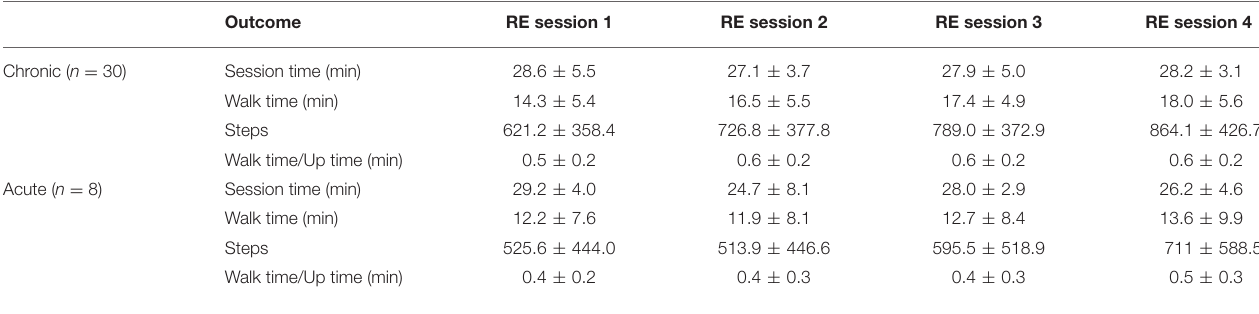
TABLE 5 | RE utilization